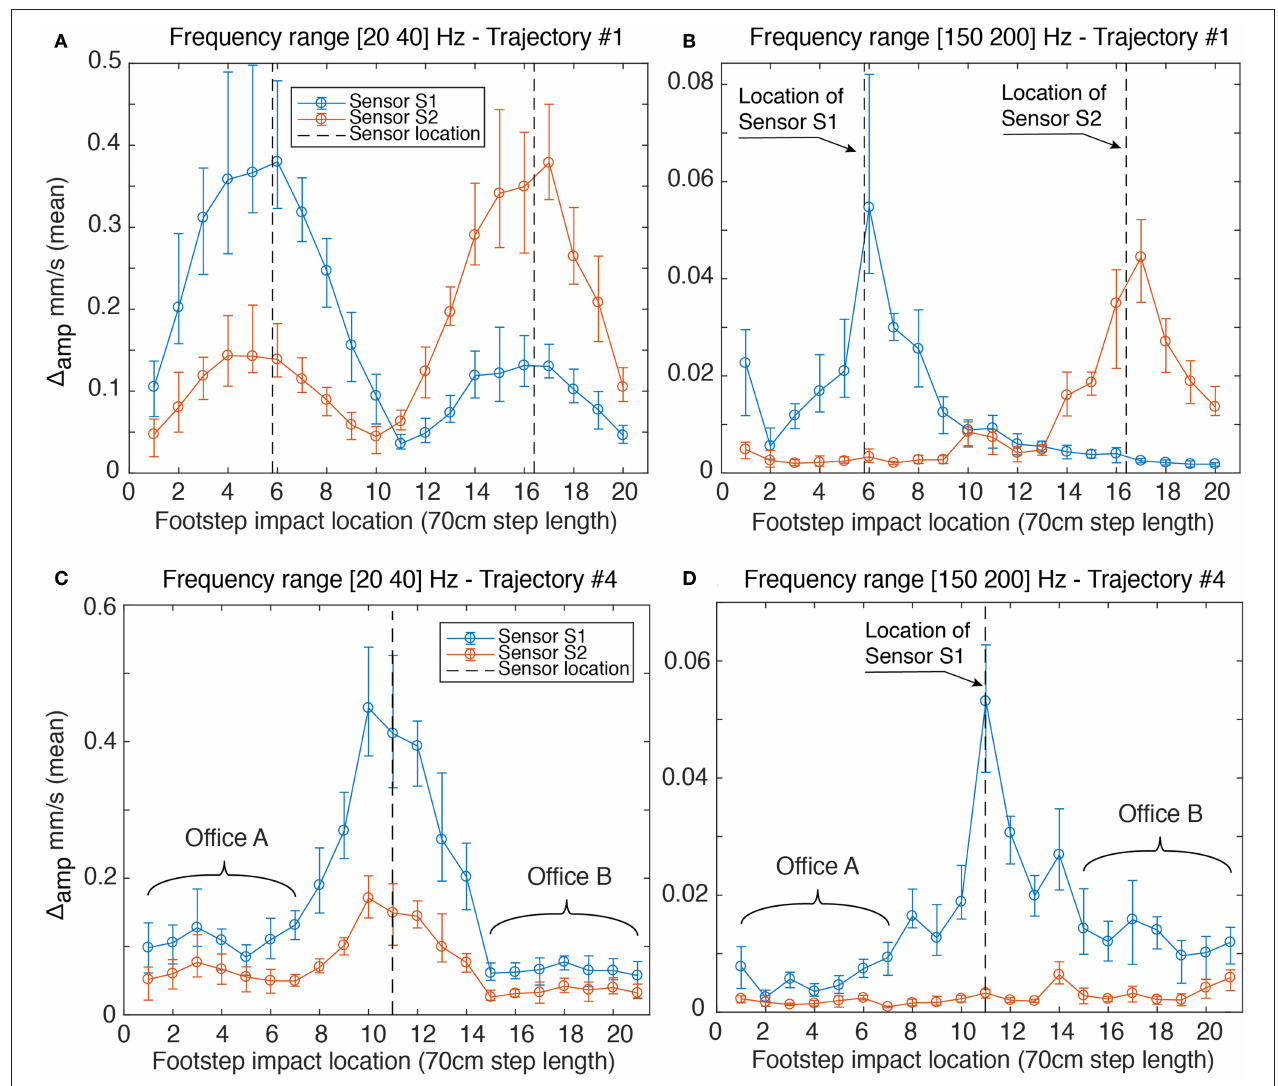
FIGURE 5 | Wavelet decomposition of footstep signals between: (A) 20 and 40Hz and (B) 150 and 200Hz for trajectory #1 (see Figure 4 ) and between: (C) 20 and 40Hz and (D) 150 and 200Hz for trajectory #4 (see Figure 4 ). Bars represent the range between minimum and maximum values of 10 prior measurements and circles correspond to the mean